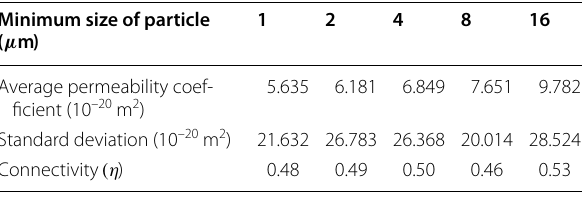
Table 4 Model simulation result for different minimum size of particle with w/c ratio-0.5.